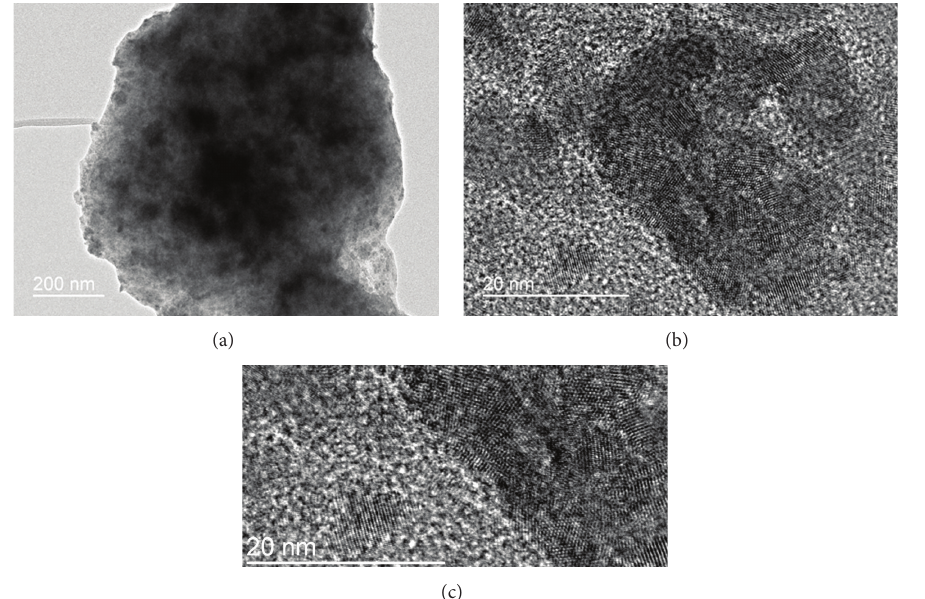
Figure 4: TEM images of catalyst composite (a) crystals encapsulated into relatively transparent chitosan, (b) agglomerated grains, and (c) CdS crystals.